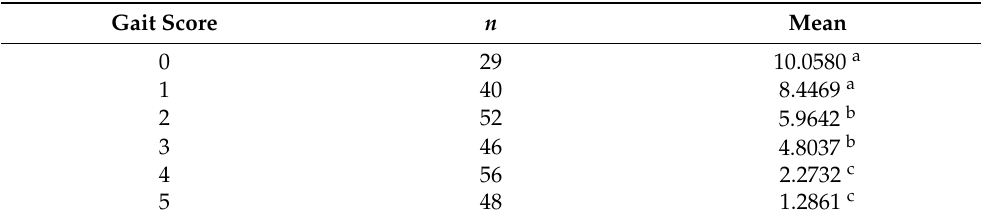
Table 2. The average walking velocity (cm/s) observed differences in the broiler footage with different known gait